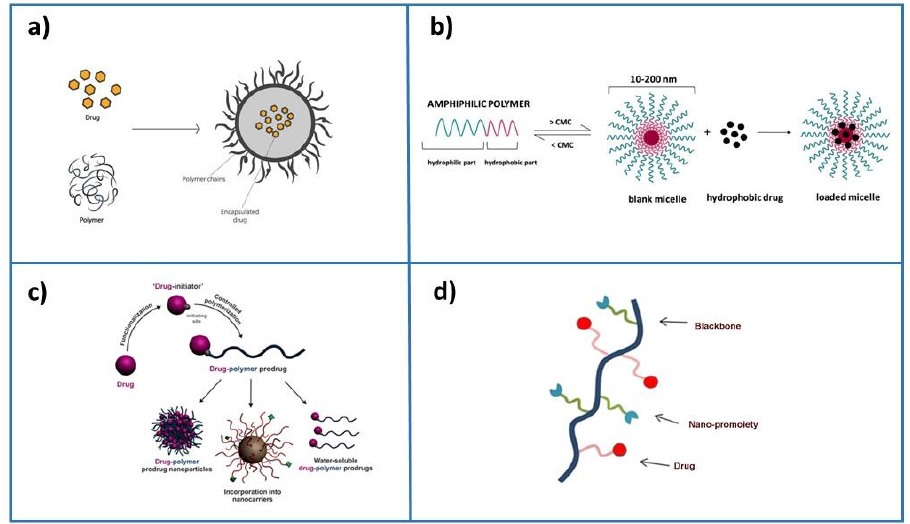
Figure 1. Principal formulation methods for drug encapsulation: ( a ) drug physical encapsulation (adapted with permission from [16]), ( b ) self-assembly of polymers and drug (adapted from [17]), ( c ) drug-initiated method (adapted from [12]), and ( d ) drug conjugation with a nano-promoiety.